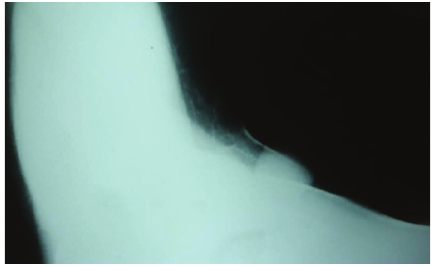
Figure 2: Mammographic picture showing the space occupying lesion in the axilla.